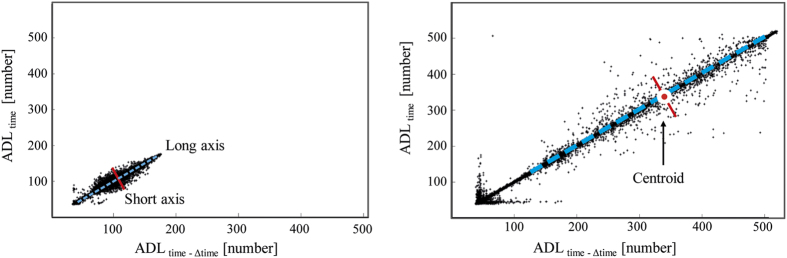
Poincaré Plot of a healthy control (Age = 79 years, female, MMSE = 29) (left) and an Alzheimer patient (Age = 84 years, female, MMSE = 20) (right) from all activity of daily living (ADL) related datasets of 20 consecutive days (Δtime = 24 hours).The blue dotted line indicates the long axis, the red line indicates the short axis. The centroid corresponds to the point where the long axis intersects the short axis.